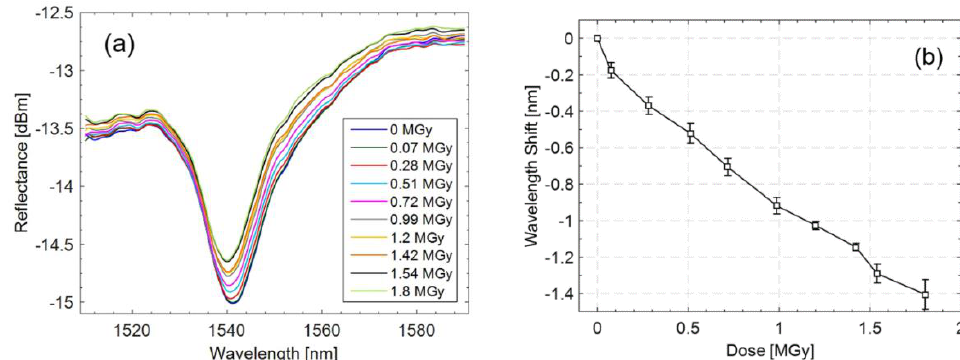
Figure 35. ( a ) LOF reflectance spectra acquired during the exposure to 23 GeV proton beam; ( b ) Calibration curve displaying the wavelength shift as a function of the dose. Reproduced with per- mission from Ref. [159] (the figure is released under a Creative Commons CC BY license http://cre-